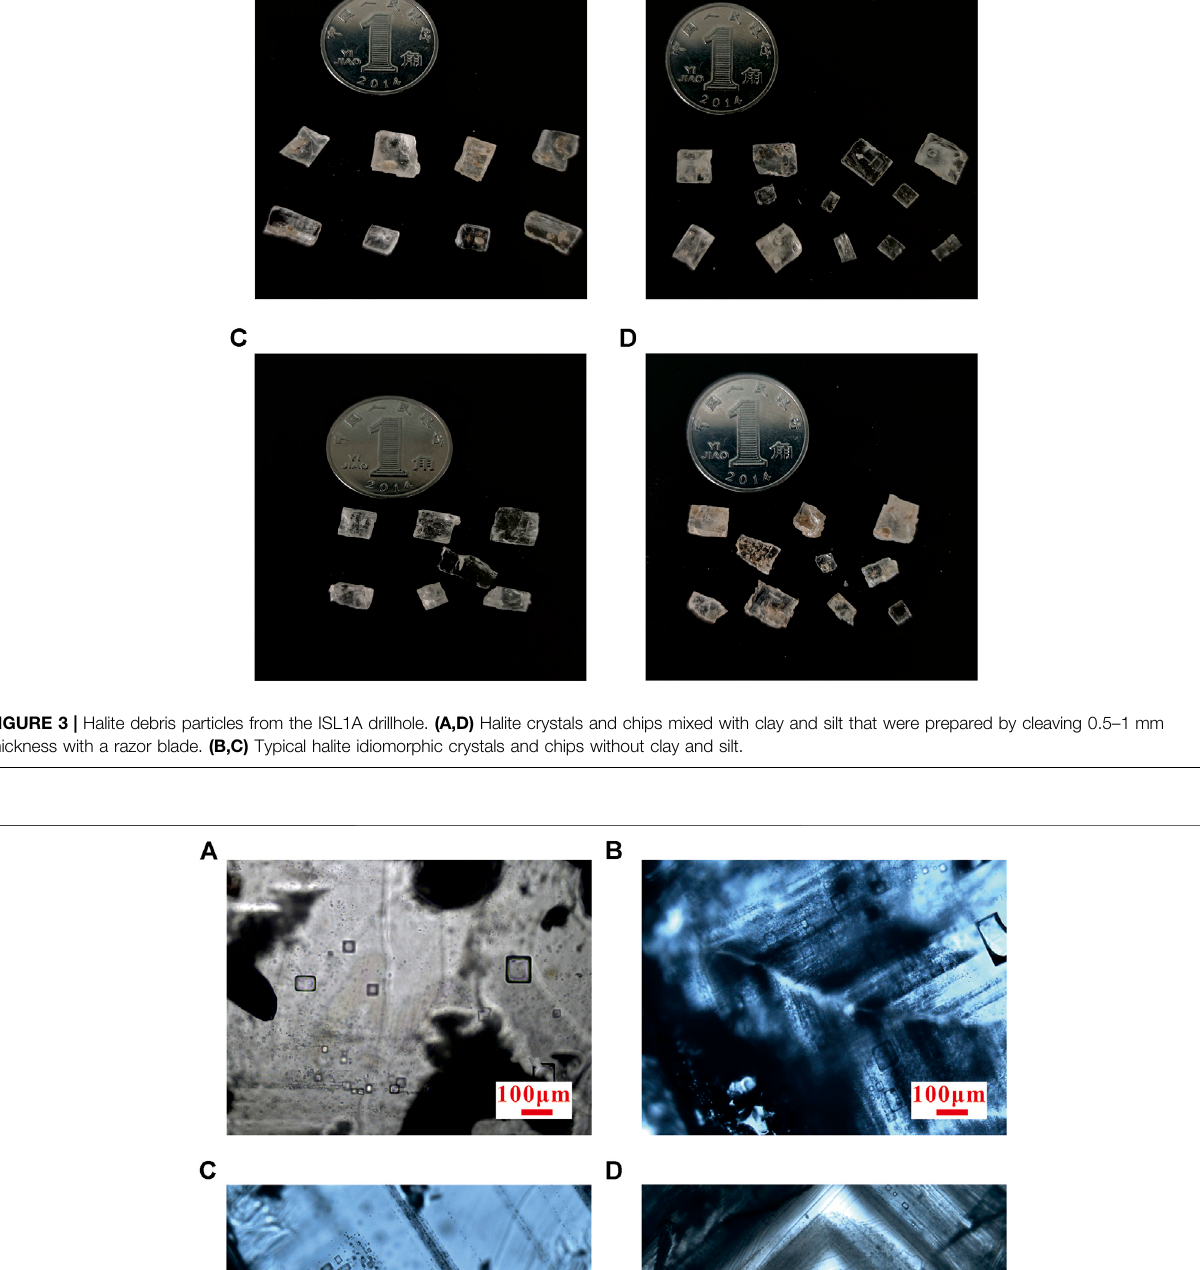
Frontiers in Earth Science |